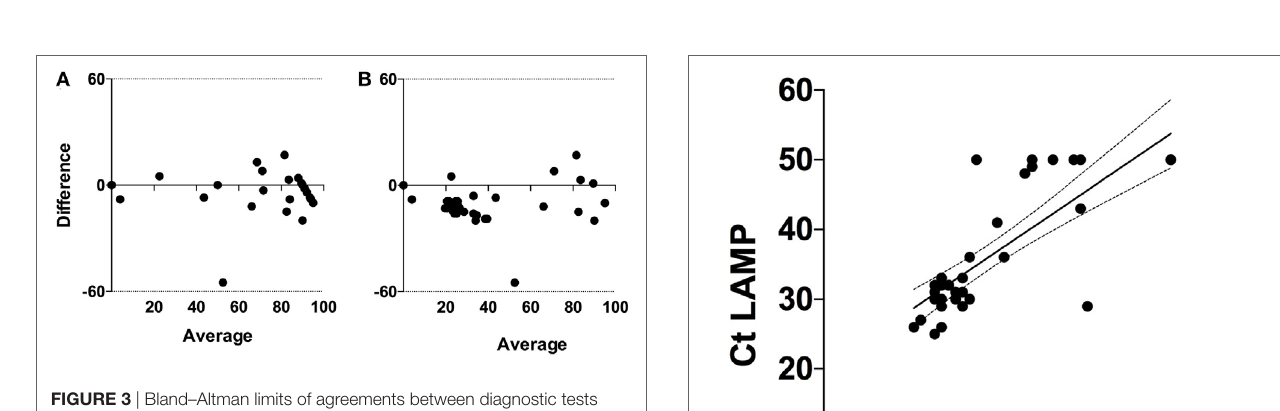
FigUre 2 | Morphological appearance of the strongylid eggs: (a,B) Trichostrongylus axei , (c) Teladorsagia circumcincta , (D) Haemonchus contortus , (e) doubtful egg type (cannot be classified as Haemonchus ), (F) Chabertia / Oesophagostomum . Characteristics of H. contortus are length 70 ± 10 μ m and width 45 ± 5 μ m plus well-developed distinct blastomeres.